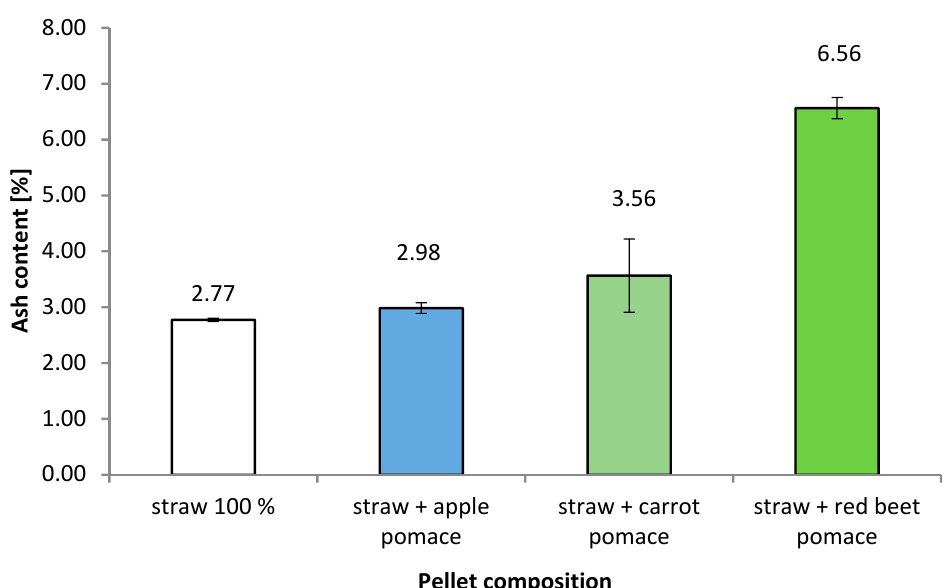
Figure 8. Ash content depending on the type of pomace addition mixed with barley straw in the substrate (at 0% and 30% contribution of additives).